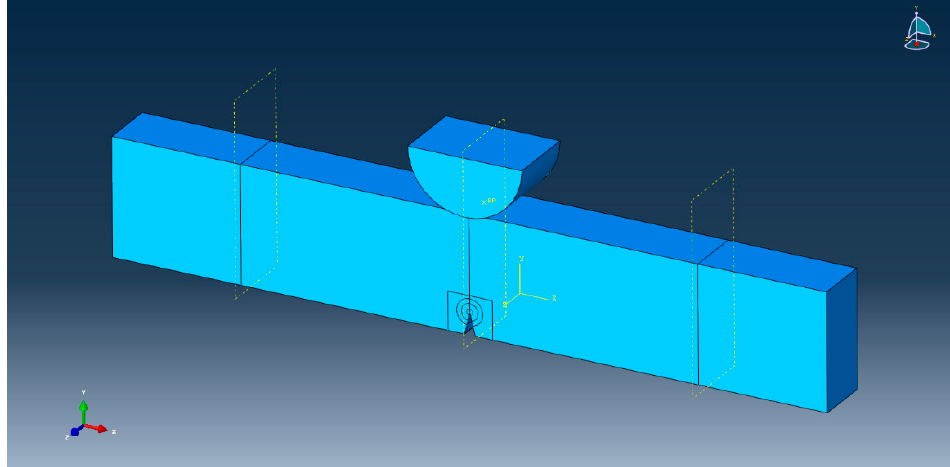
Figure 6. Assembly of the simulated test specimen.